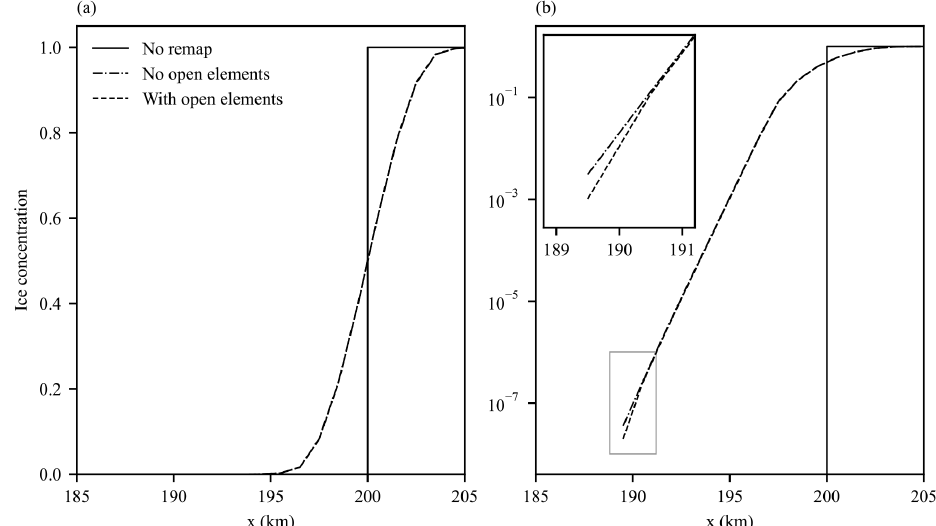
Figure 3. (a) Detail of ice concentration for the top hat test case showing the higher-order remapping results with and without taking into account the effect of open water. (b) As (a) but with a logarithmic ordinate axis. The inset shows detail of the differences at the extreme of the